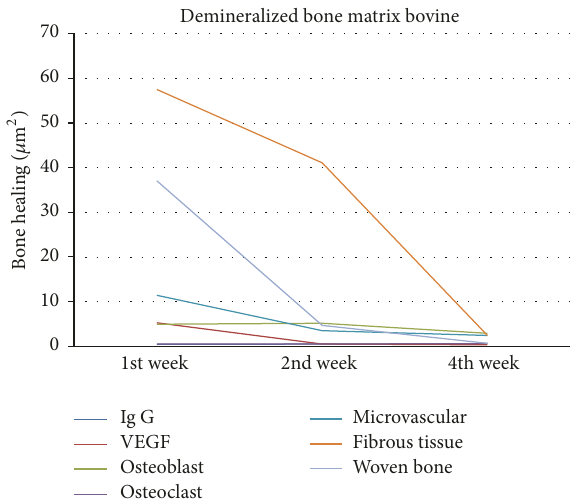
Figure 13: Bone healing in demineralized bone matrix bovine group.